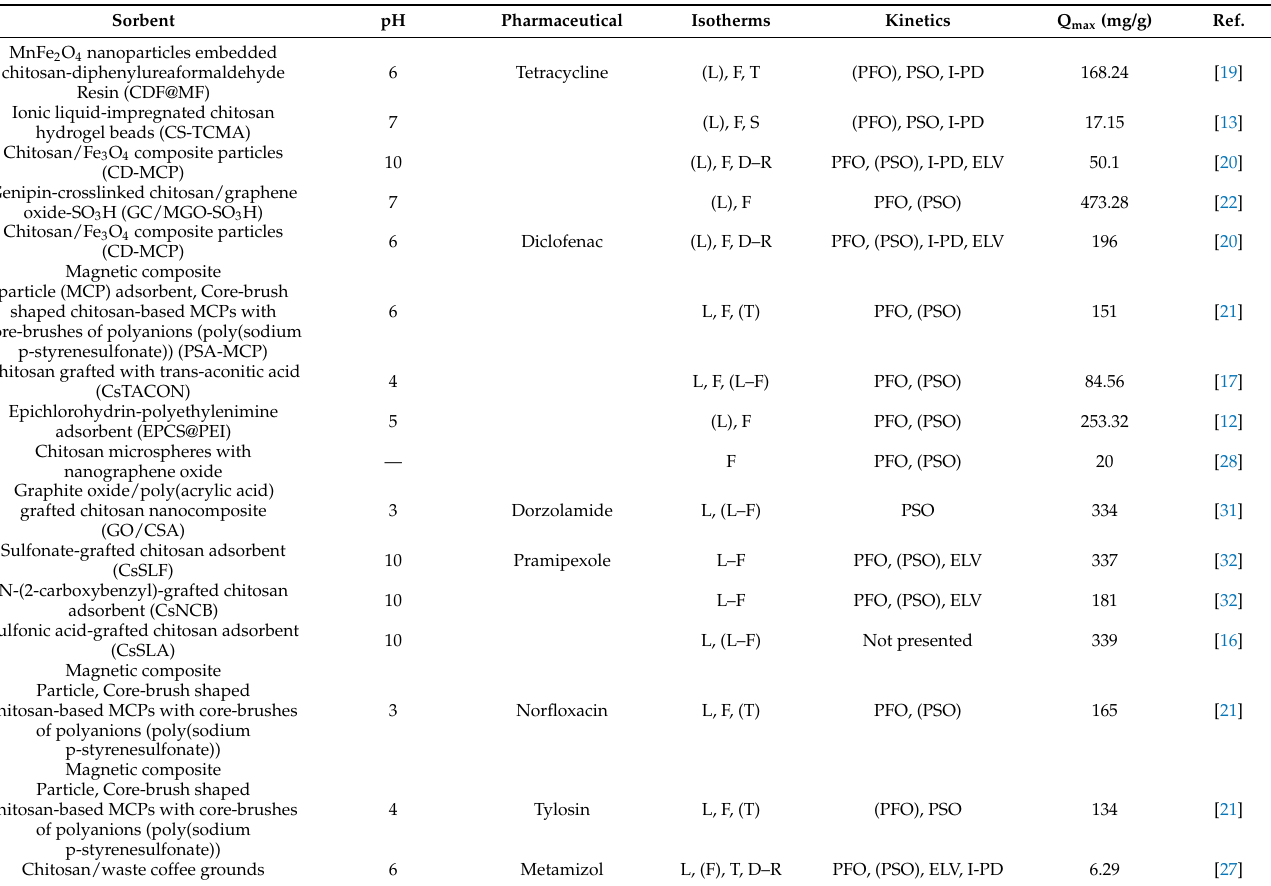
Table 1. Selected studies for the adsorption of pharmaceutical compounds from aqueous solutions at 25 ◦ C using modified chitosan adsorbents. The optimum mathematical fitting of isotherm and kinetic models, derived from the experimental results after the adsorption process, are abbreviated with parenthesis. Sorbent pH Pharmaceutical Isotherms Kinetics Q max (mg/g)